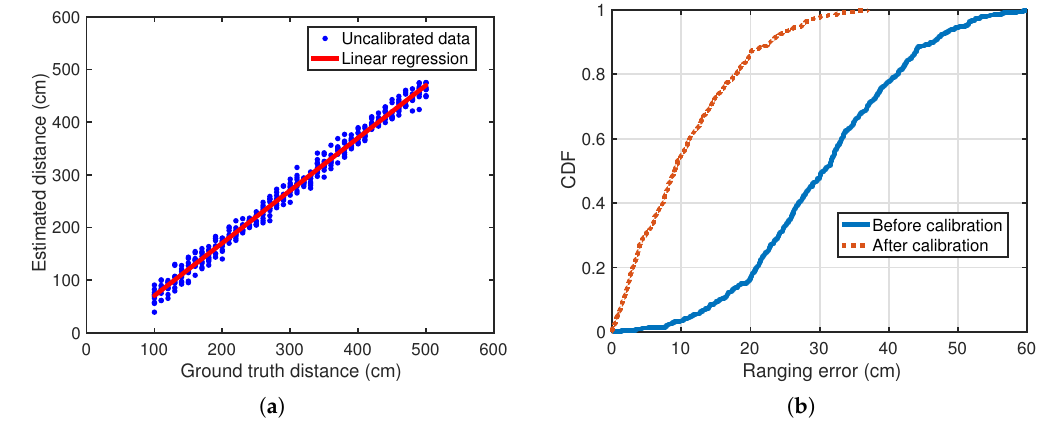
Figure 19. ( a ) Real distances vs. calculated distances in the calibration. ( b ) CDF plot of ranging errors for both before and after the compensation.